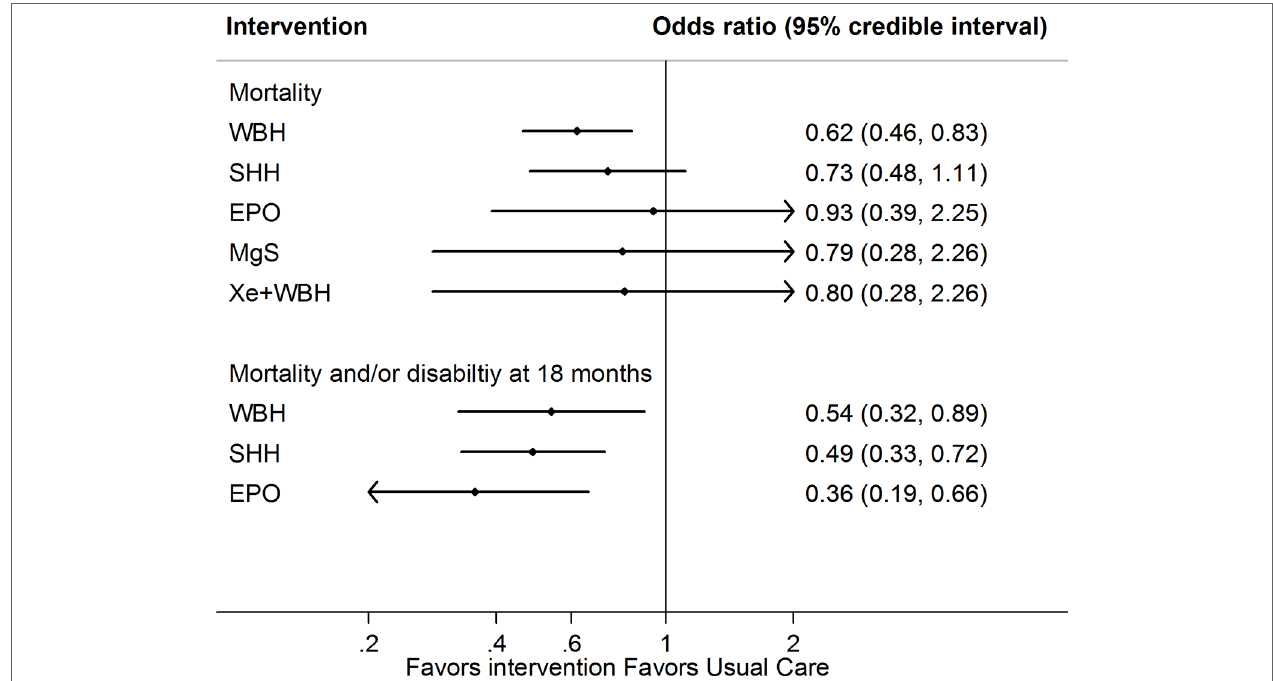
FIGURE 2 | Network meta-analysis forest plots for each treatment versus usual care on mortality or mortality and neurodevelopmental delay at 18 months outcome. Each rhombus represents the summary treatment effect estimated in the network meta-analysis on the odds ratio (OR) scale. The black horizontal lines represent the credible intervals (CrI) for the summary treatment effects; an OR > 1 suggests that usual care is more effective to reduce the risk of mortality, whereas an OR < 1 suggests that the comparable treatment is better. The vertical blue line corresponds to an OR =